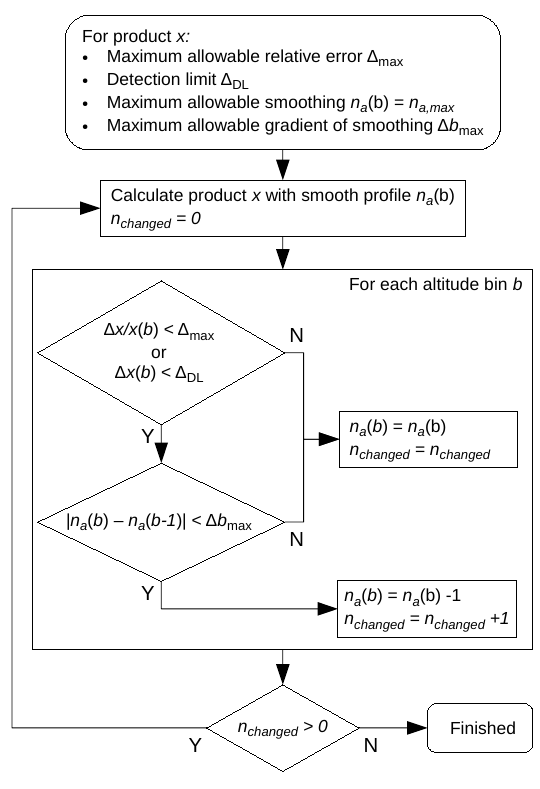
Figure 3. Work flow diagram of the automatic algorithm for vertical smoothing implemented in